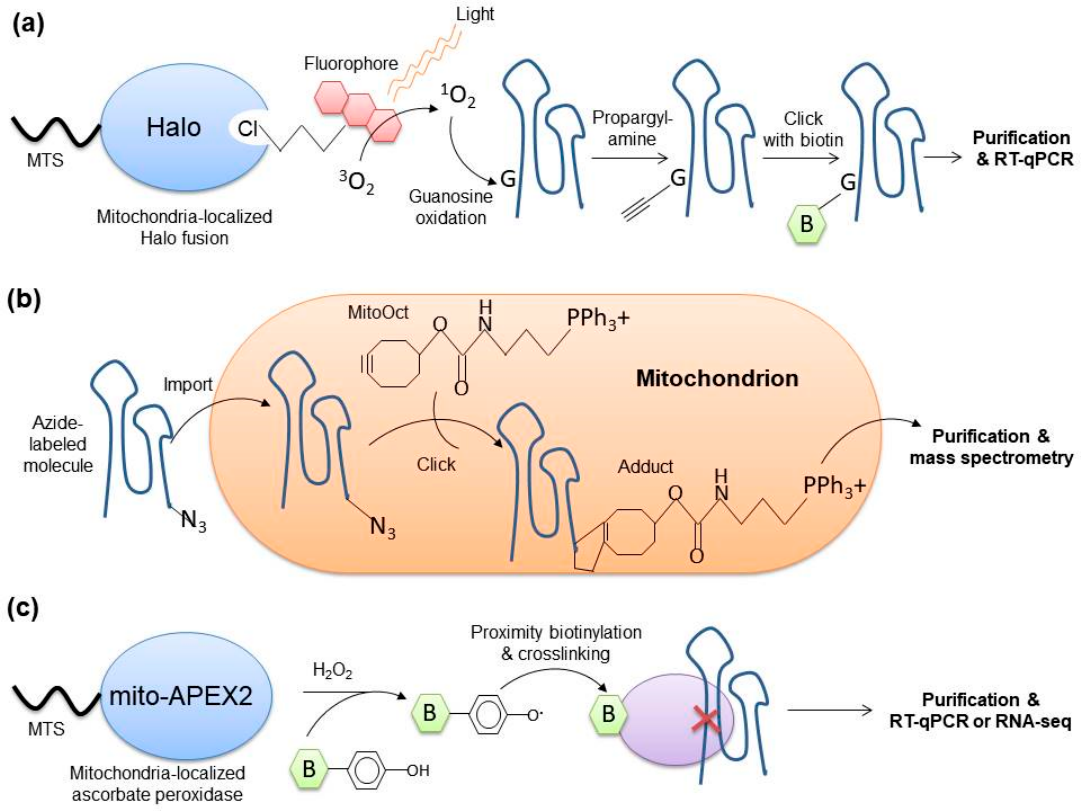
Figure 7. Detection of mitochondrial RNAs with spatially restricted tagging and crosslinking techniques: ( a ) spatially restricted guanosine oxidation [152,153], ( b ) ClickIn [154], ( c ) APEX-RIP [155] and Proximity-CLIP [156]. See main text for